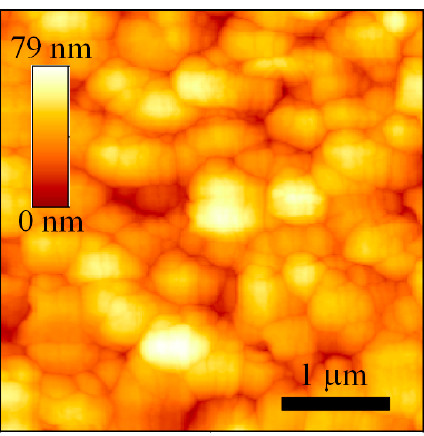
Figure 5. The atomic force microscopy (AFM) images of the surface of thin-film Ge. The surface is rough due to the smart-cut process.